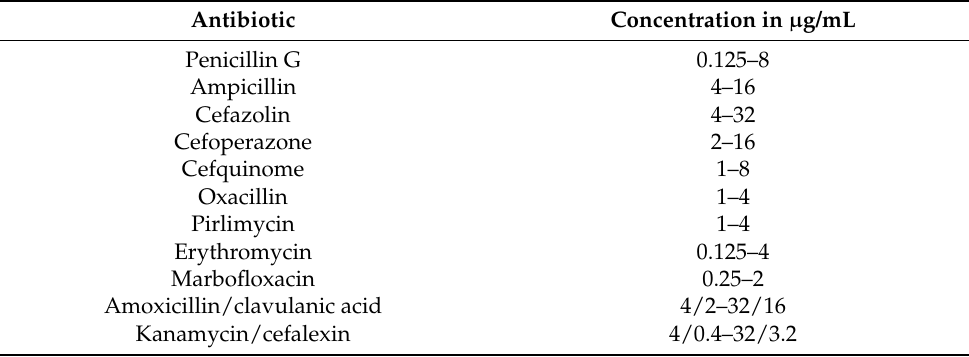
Table 2. Tested antibiotics and concentration